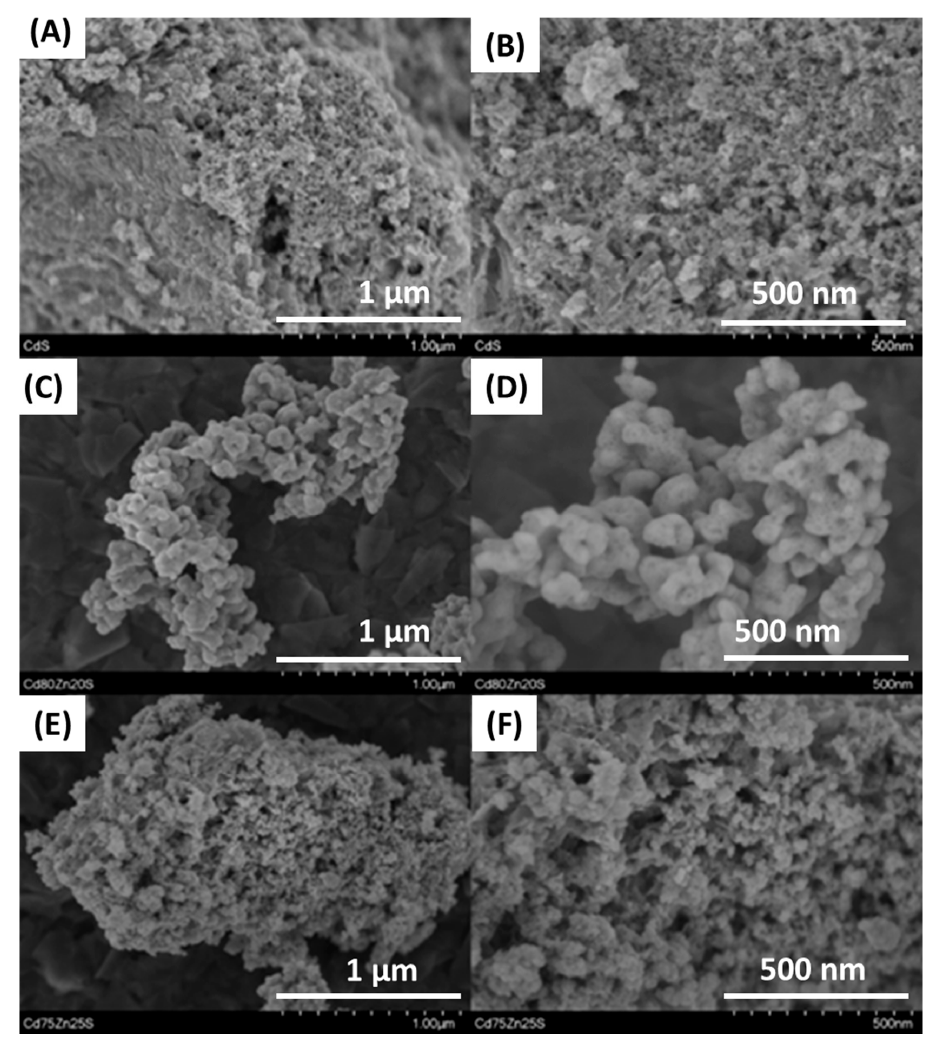
Figure 2. SEM images of pure CdS ( A , B ), Cd 0.8 Zn 0.2 S ( C , D ) and Cd 0.75 Zn 0.15 S ( E , F ) solid solutions.